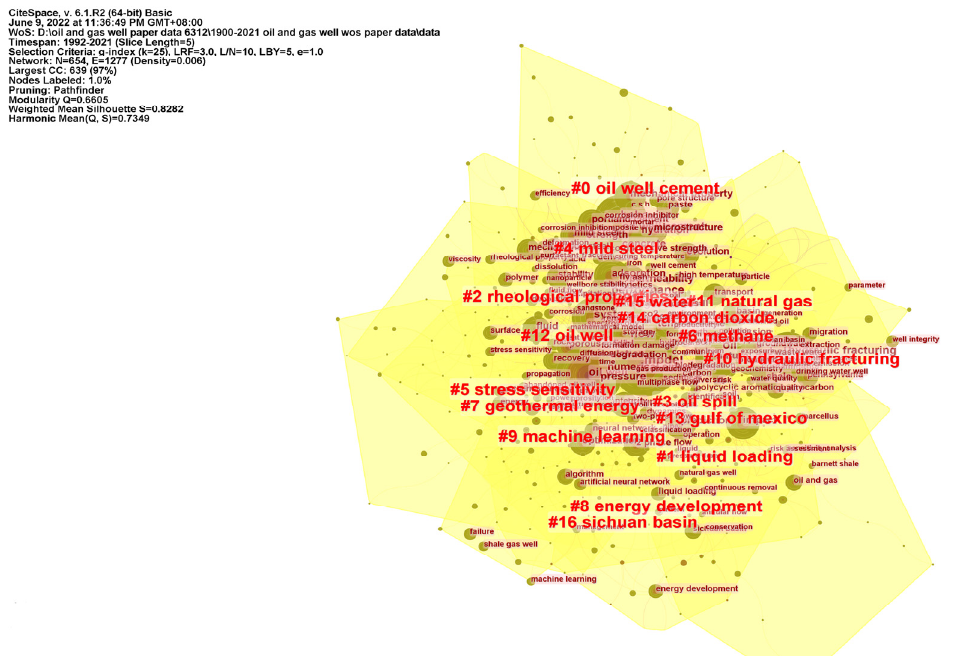
Figure 13. Seventeen clusters of keyword co-occurrence networks in the field of oil and gas wells generated by CiteSpace, 1992–2021.